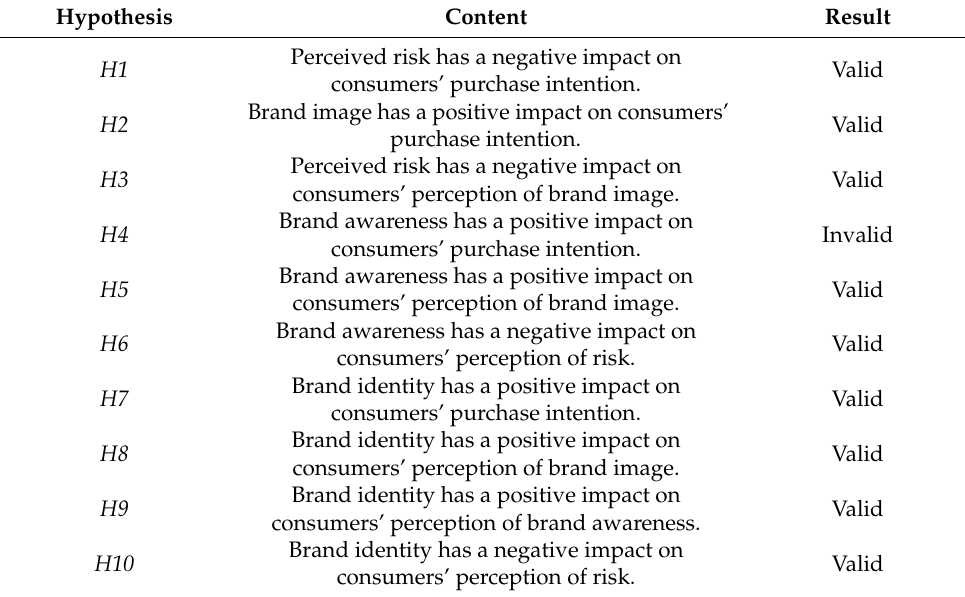
Table 11. The hypothesis verification results of this